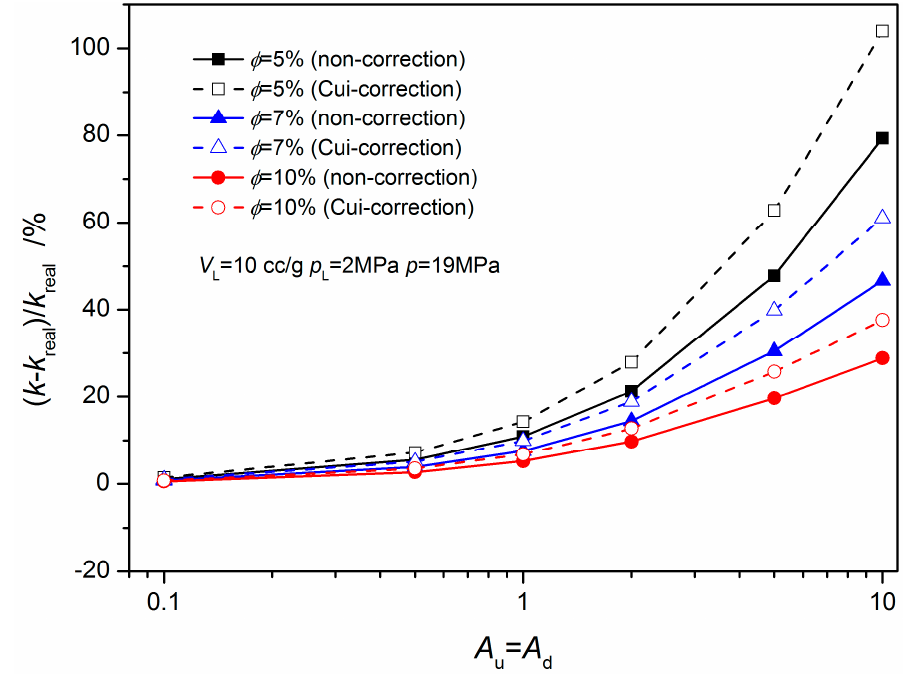
Figure 16. The influence of porosity on the tested permeability.